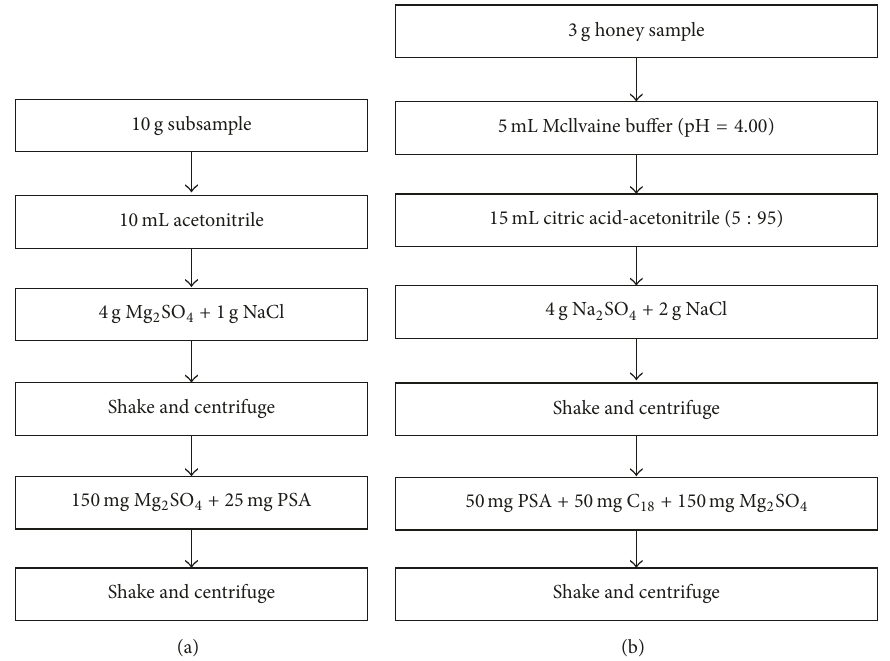
Figure 2: Original QuEChERS methodology (a) and modified QuEChERS methodology